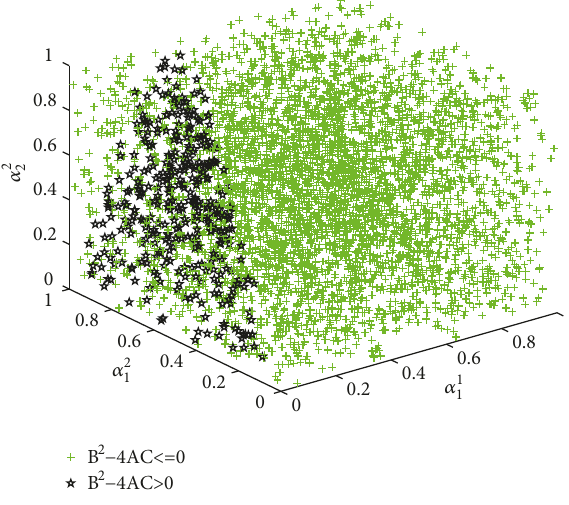
Figure 1: Blue + signs denote cases for Δ = 𝐵 2 − 4𝐴𝐶 ≤ 0 ; black ⋆ signs indicate cases for Δ = 𝐵 2 − 4𝐴𝐶 > 0 . Here, 𝐴, 𝐵 , and 𝐶 are from Theorem